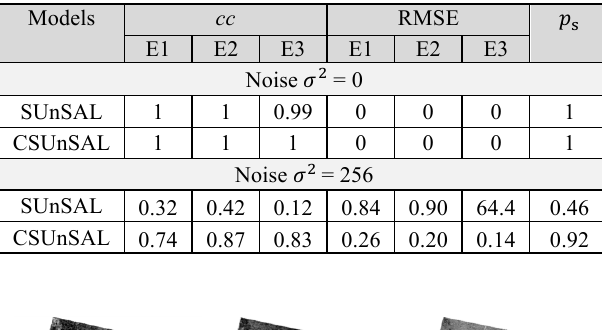
Table 1. Cc, RMSE and 𝑝 ! for endmember 1, 2, and 3 (E1, E2, E3) for noise variance 0 and 256